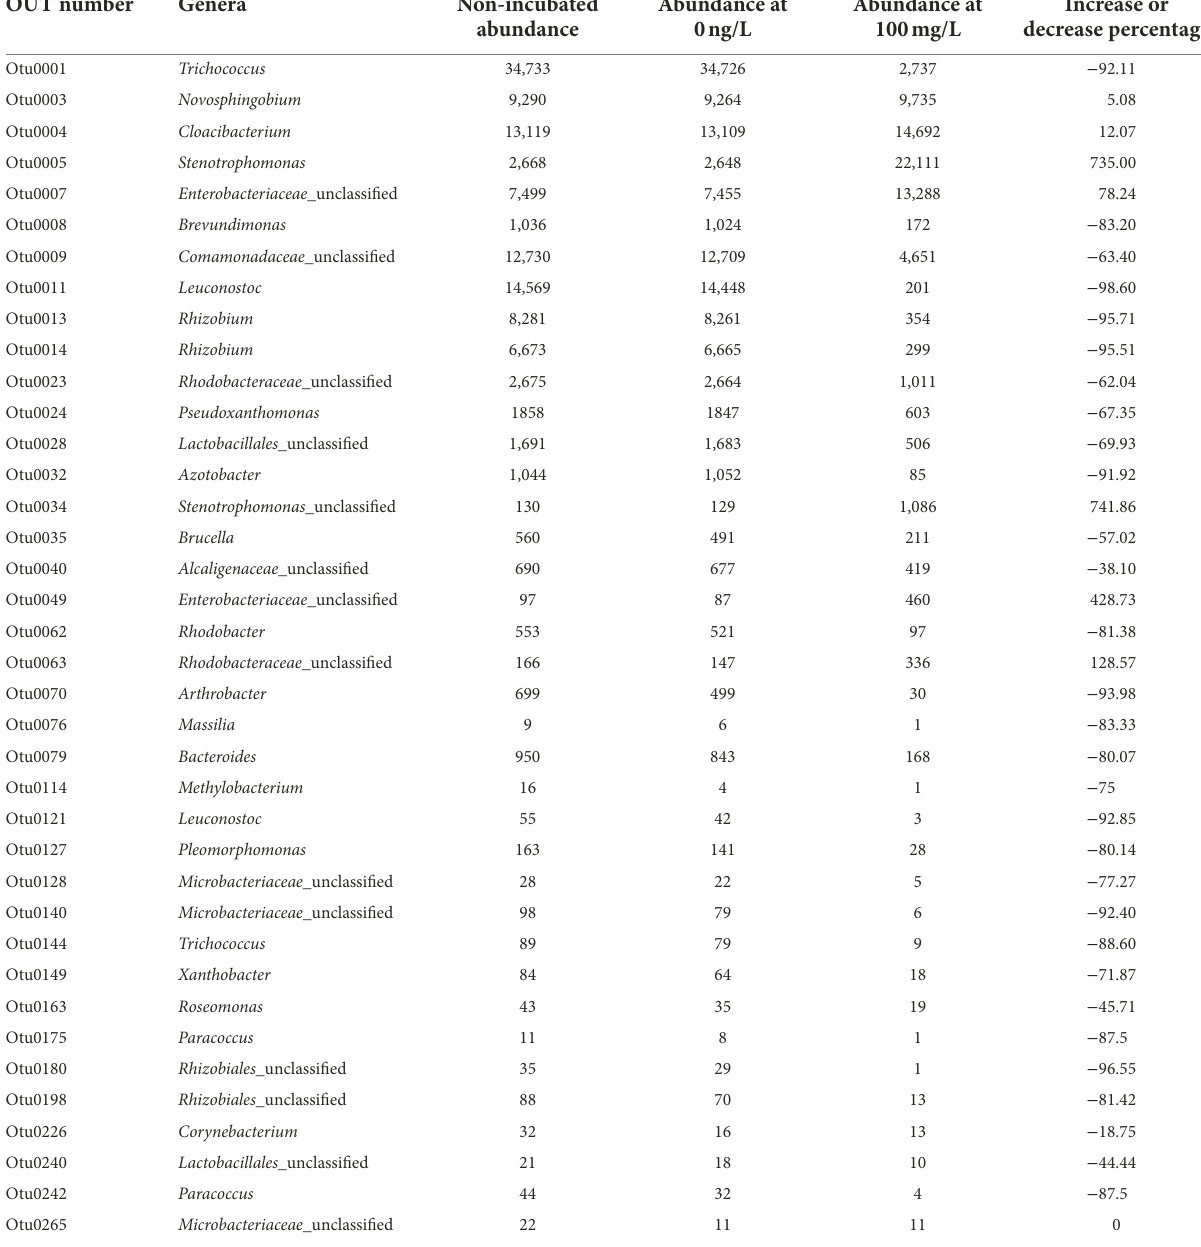
TABLE 2 Proportion of the 38 shared OTUs between 0 ng/L and 100 mg/L concentrations and highlighting an increased or decreased